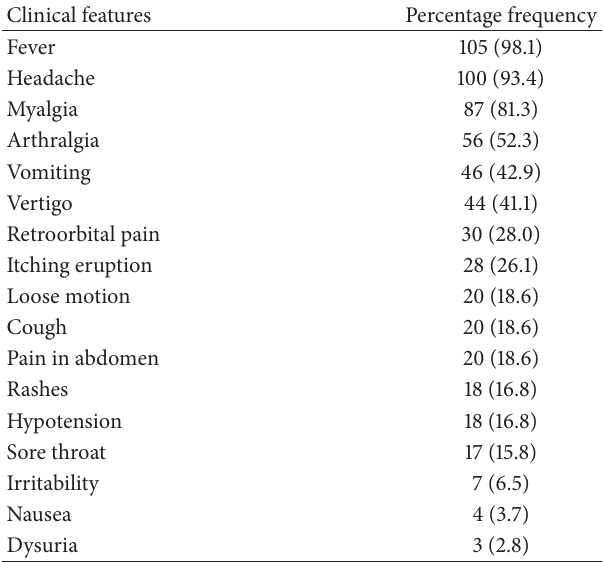
Table 1: Clinical characteristics of Dengue-positive